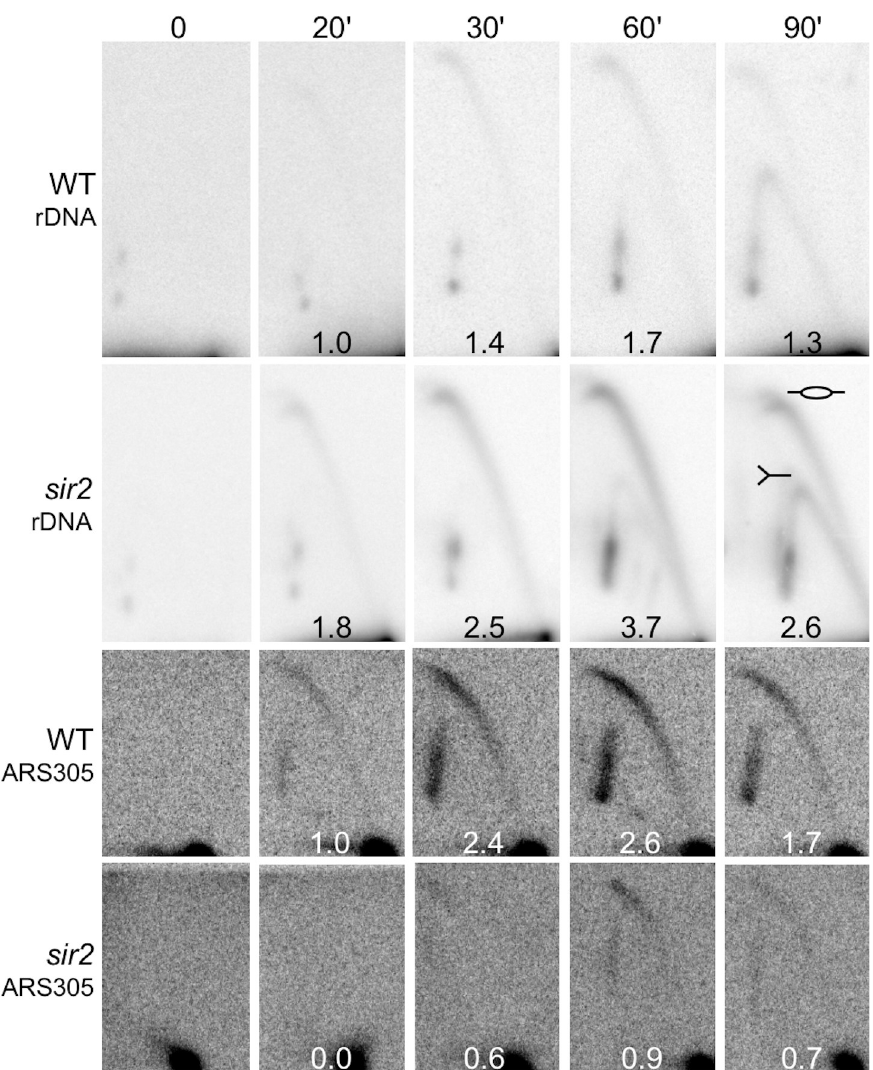
Fig 5. 2D gel analysis of origin activity at rDNA and ARS305. WT (16535) and sir2 (16560) cells, that carry 172 and 155 rDNA copies, respectively, were arrested in G1 with alpha factor, released into medium with 200 mM hydroxyurea, samples were collected at times 0, 20’, 30’, 60’ and 90’ and analyzed by 2D gel electrophoresis. DNA was cut with NheI for rDNA origin and EcoRV for ARS305. Replication bubble abundance was calculated by densitometry as a ratio of bubble to linear DNA signal, expressed relative to the 20’ time point in WT cells for each of the two replication origins.